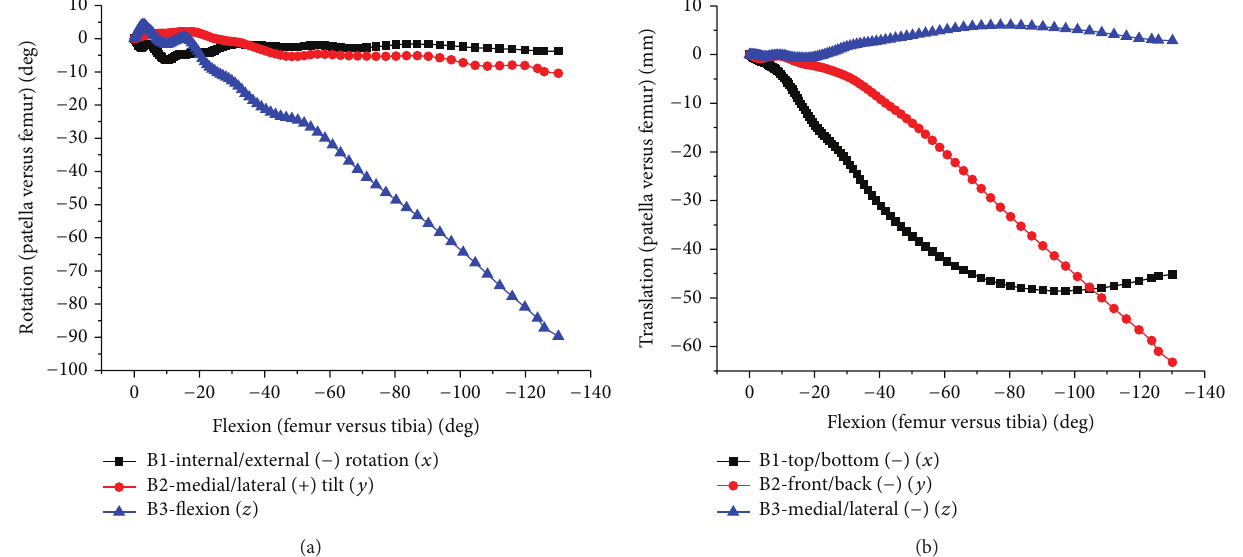
Figure 14: The relative movement of patellofemoral joint. (a) Internal/external, abduction/adduction, and flexion of patellofemoral joint. (b) Translation of patellofemoral